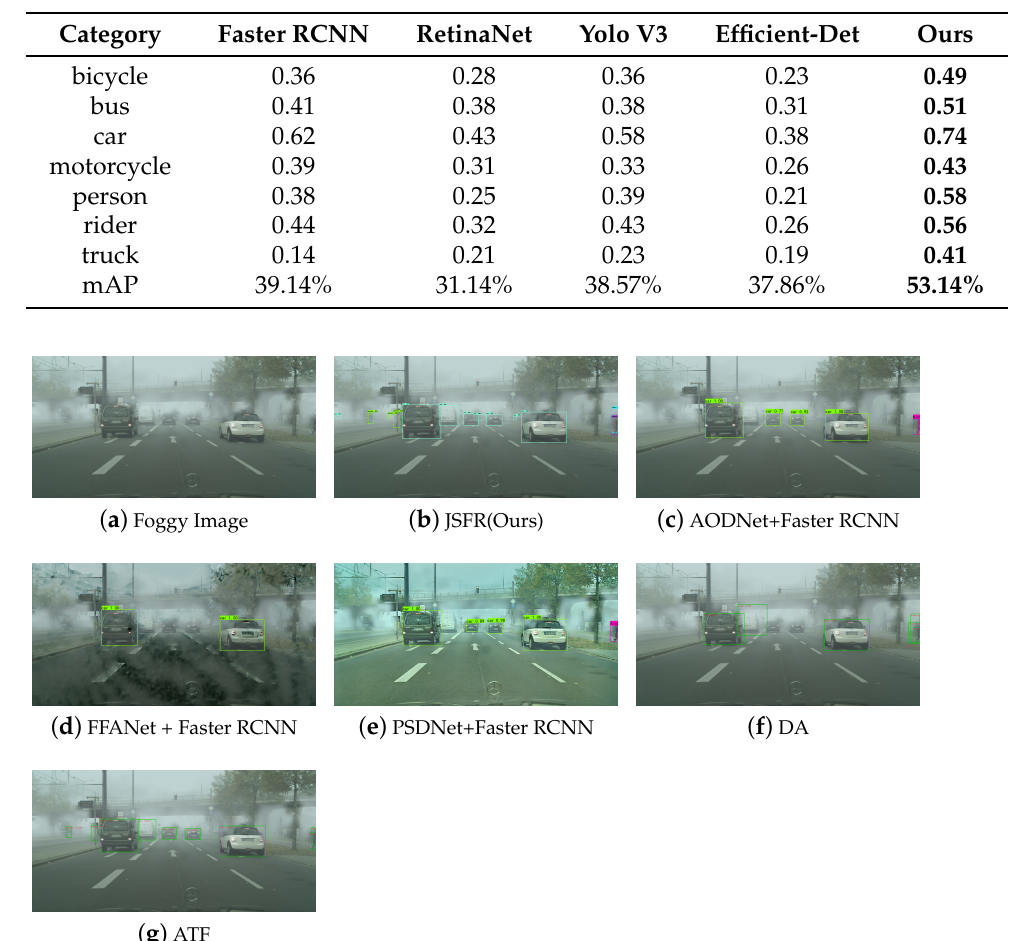
Table 1. Comparison of AP and mAP between JSFR and object detection methods including Faster RCNN , RetinaNet , Yolo V3 , and Efficient-Det .